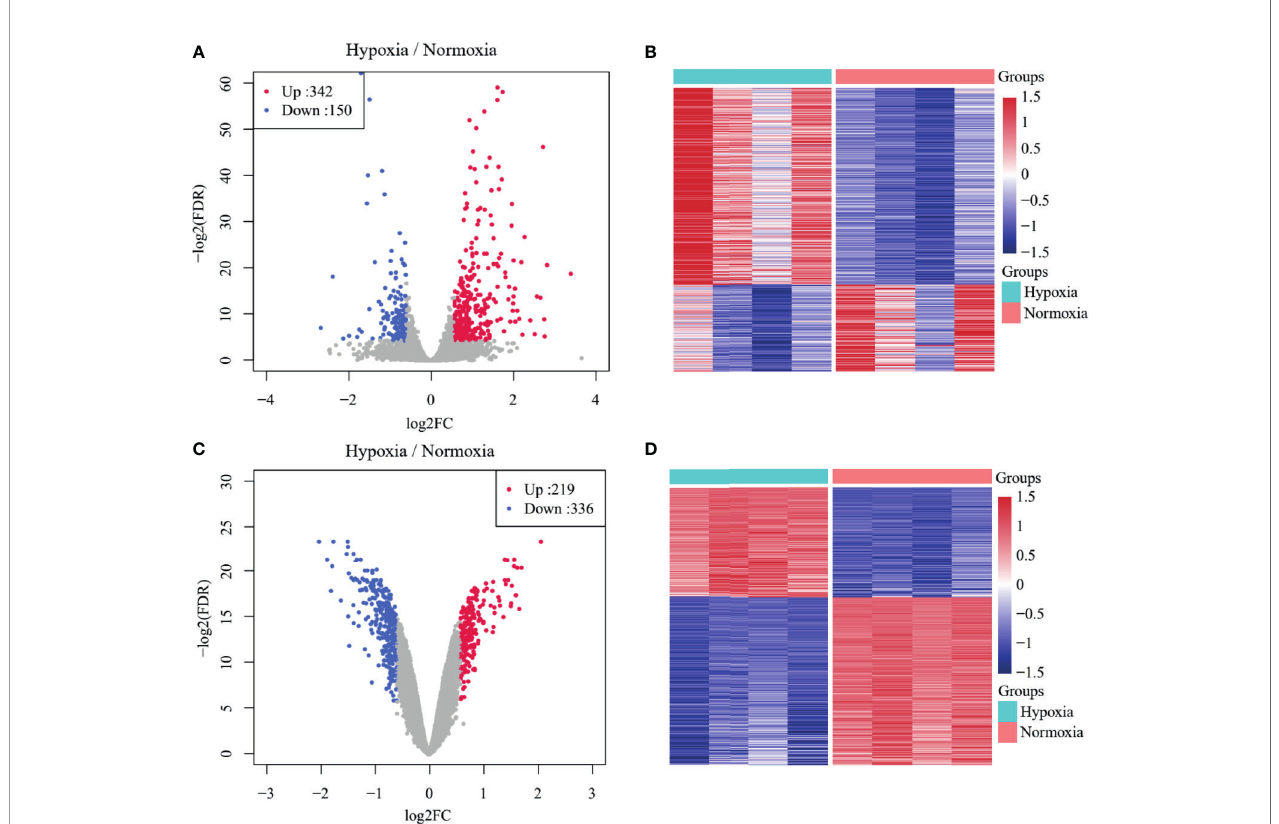
FIGURE 1 | Identi fi cation of TNBC-speci fi c hypoxia-related genes (HRGs). (A) Volcano plot of differentially expressed genes (DEGs) between normoxic and hypoxic cultured breast cancer cells in GSE104193. (B) Heat map of DEGs between normoxic and hypoxic cultured breast cancer cells in GSE104193. (C) Volcano plot of DEGs between normoxic and hypoxic cultured breast cancer cells in GSE33950. (D) Heat map of DEGs between normoxic and hypoxic cultured breast cancer cells in